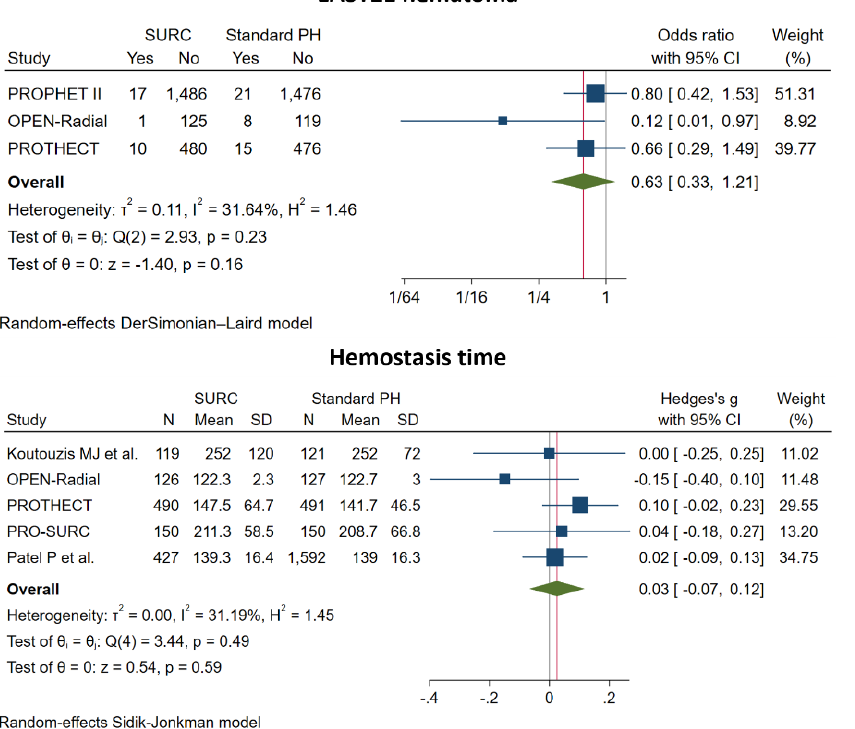
Figure 4. Pooled analysis of studies comparing simultaneous ipsilateral and ulnar artery compression versus isolated radial artery compression. Forest plot reporting trial-specific and summary odds ratio (OR) and standardized mean difference (SD) with 95% confidence interval (CI) for the endpoint of Early Discharge After Transradial Stenting of Coronary Arteries (EASY) ≥1 hematoma and hemostasis time. PH, Patent Hemostasis.